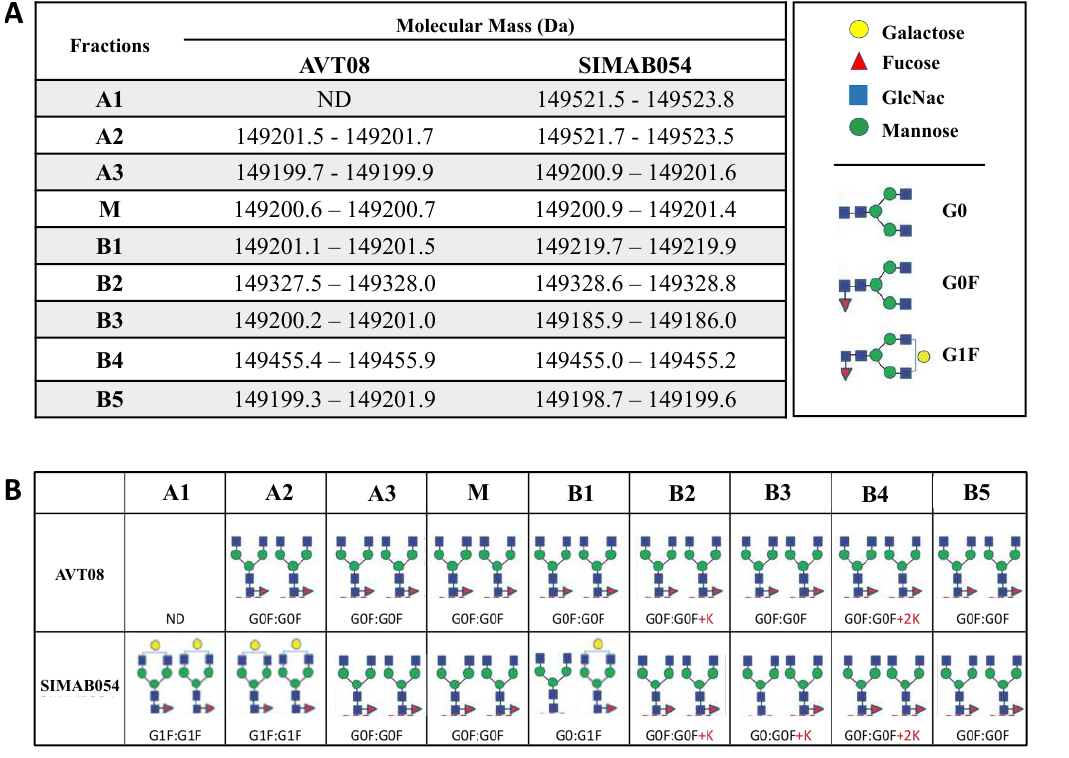
Figure 4. Intact protein analysis of charge variant fractions obtained from AVT and SIMAB054. ( A ) The list of the molecular mass of the dominant mass peak in each fraction. Each fraction was injected three times, and the mass ranges represent the minimum–maximum observed mass values. A, M, and B represent acidic, main, and basic fractions. ( B ) Illustration of glycoforms assigned for each molecular